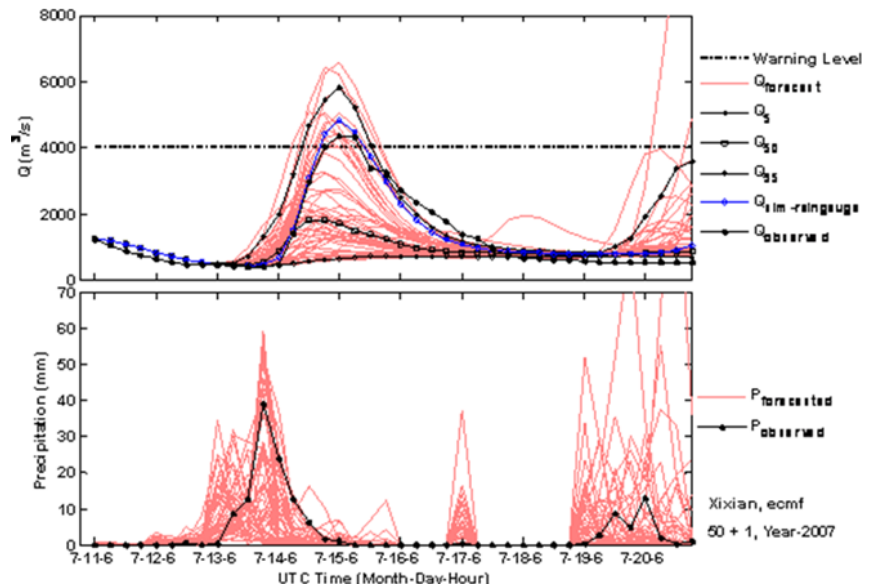
Fig. 4. Ensemble precipitation forecasts issued on 11 July 2007 by “ECWMF” (lower) and ensemble forecast discharges (upper) in compar- ison with observation.